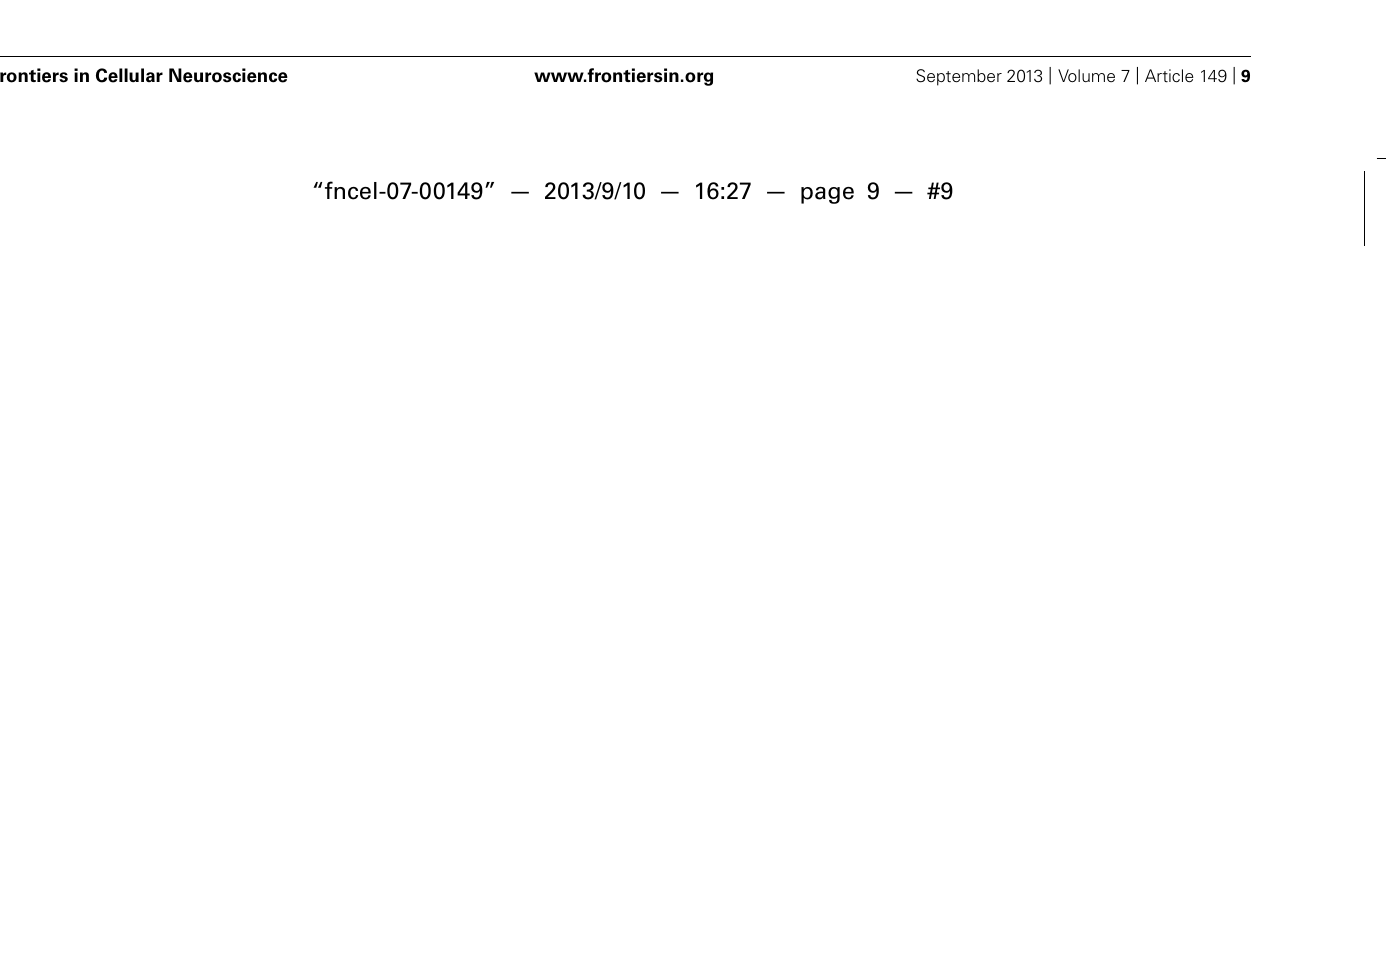
neuronal Ca 2 + oscillations in control neurons and decreases both Ca 2 + oscillations in astrocytes and Ca 2 + superoscillations in Hyase-treated neurons. (D) Number of astrocytic Ca 2 + oscillations.There is no difference between the control and Hyase-treated groups. CPP, ( ± )-3-(2-carboxypiperazin-4-yl)propyl-1-phosphonic acid, 10 μ Ì; CNQX, 6-cyano-7-nitroquinoxaline-2,3-dione, 10 μ Ì; Hyase, hyaluronidase; DZM, diltiazem, 10 μ M. Mean ± SEM values are shown, * p < 0.05; ** p < 0.001 indicate significant differences by ANOVA, N =